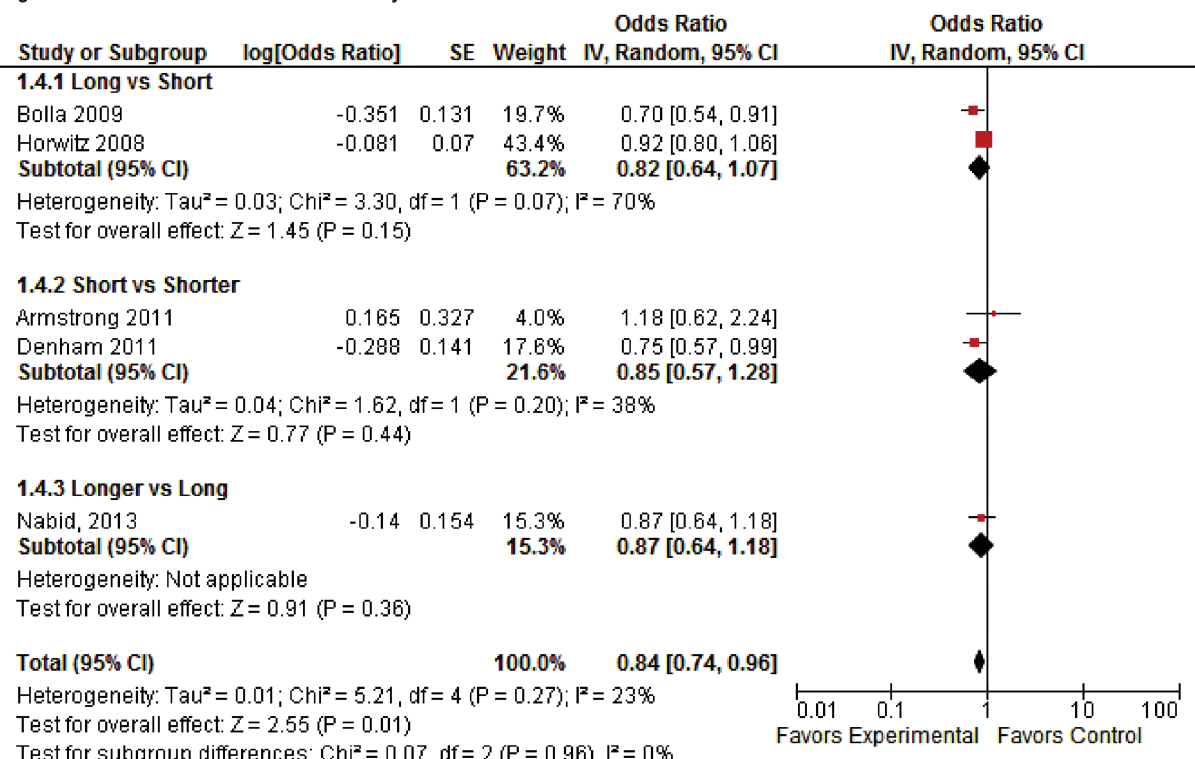
Figure 2 - Overall Survival - Pooled